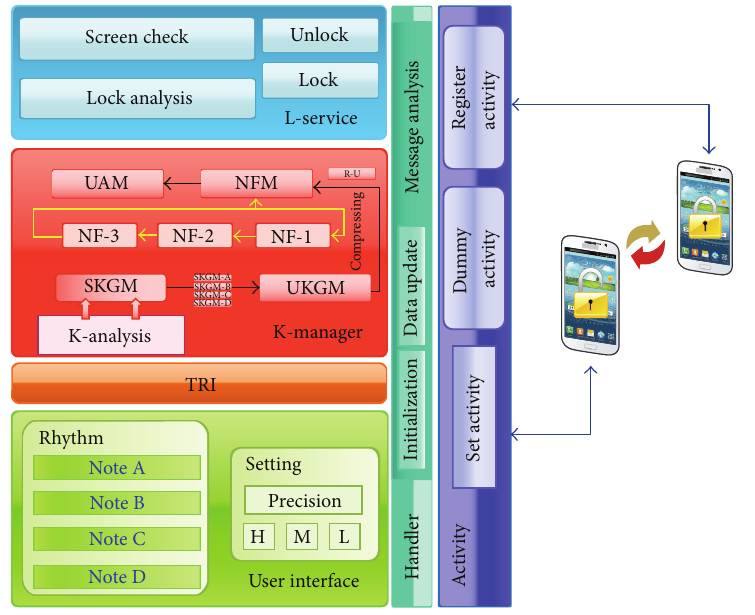
Figure 4: Architecture of RLS.